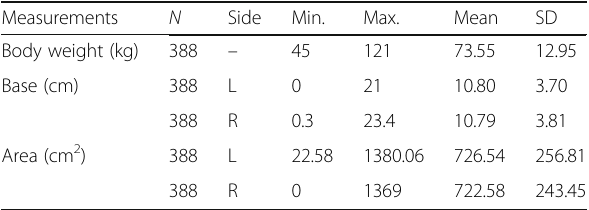
Table 1 Descriptive statistics of body weight, base of gait, and area swept in one stride